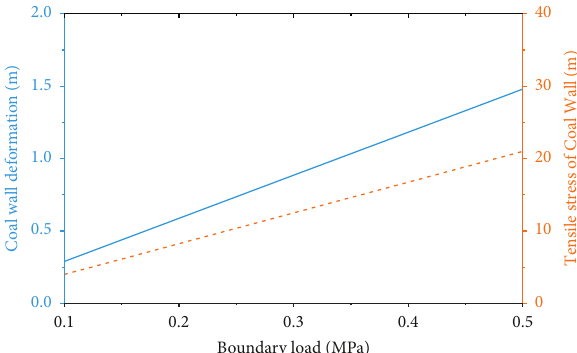
Figure 8: Influence of the load q (Figure 2) on the stability of the coal